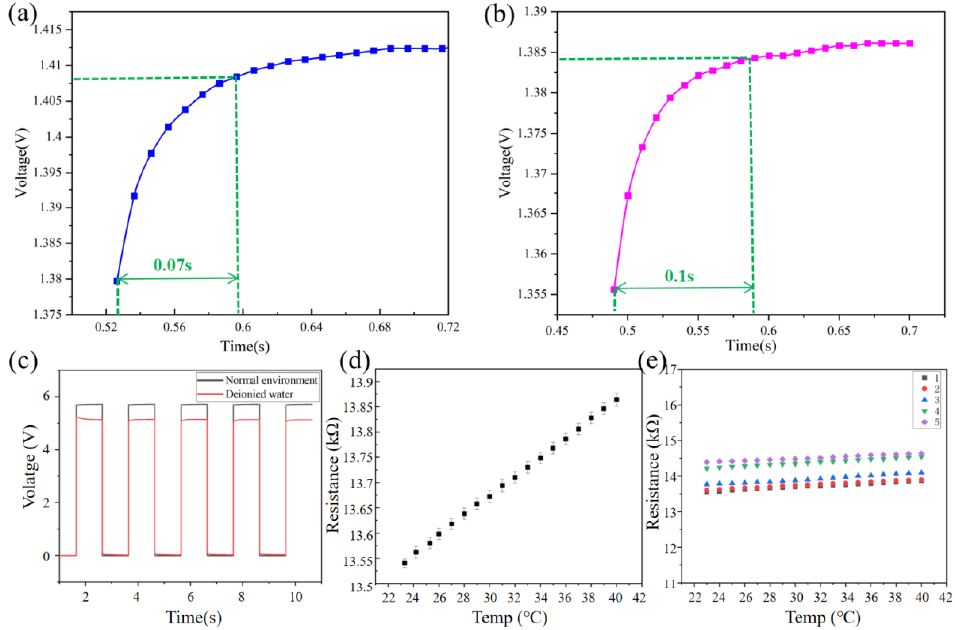
Figure 5. ( a ) Test the response time of the sensor in air. Test of constant current in Electrochemical Workstation. ( b ) Test the response time of the sensor in deionized water. ( c ) Pulse test in air and deionized water. ( d ) Repeatability of temperature test of the sensor. ( e ) Repeatability of temperature test of five sensors.